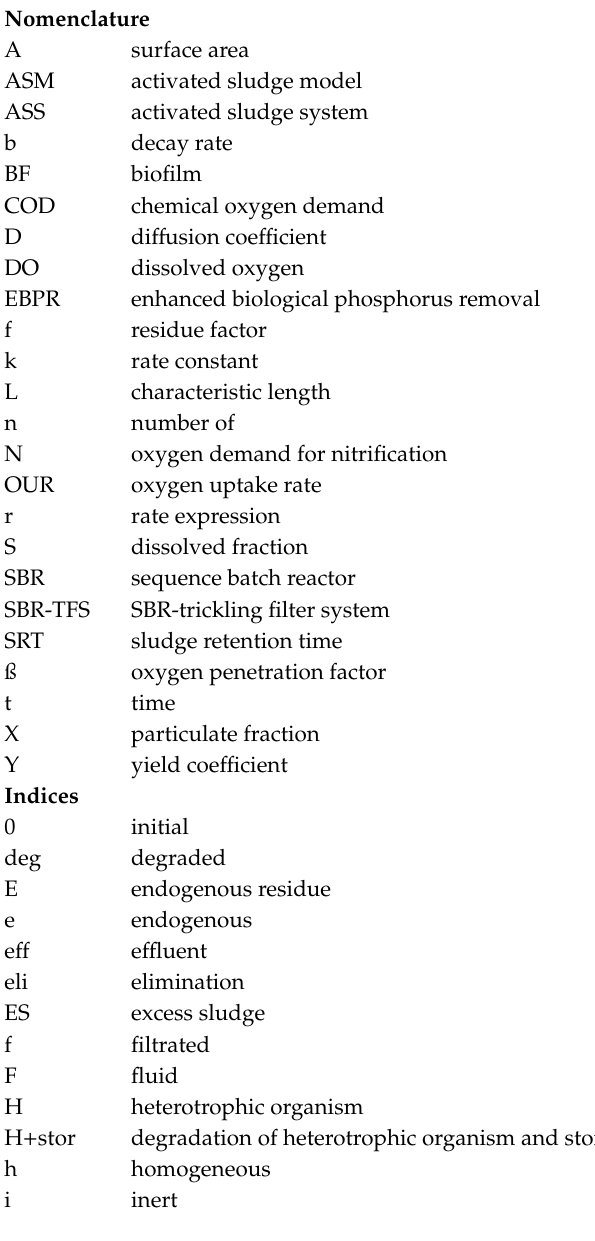
Figure S1: Di ff usion limitation with respect of oxygen penetration into the